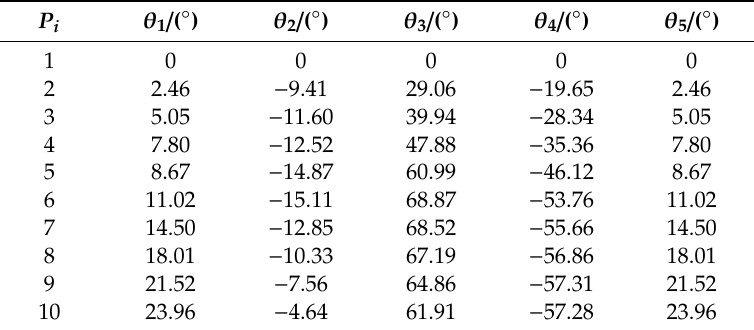
Table 5. Joint angles of the pickup manipulator at path points.